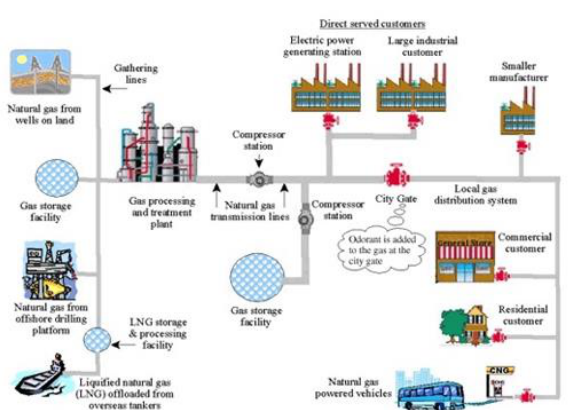
Figure 1. Natural Gas Pipeline Network Components